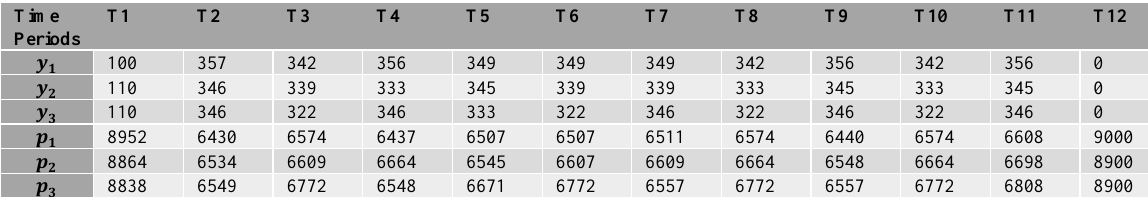
Table 3. Optimal value of sales and price (In Units).